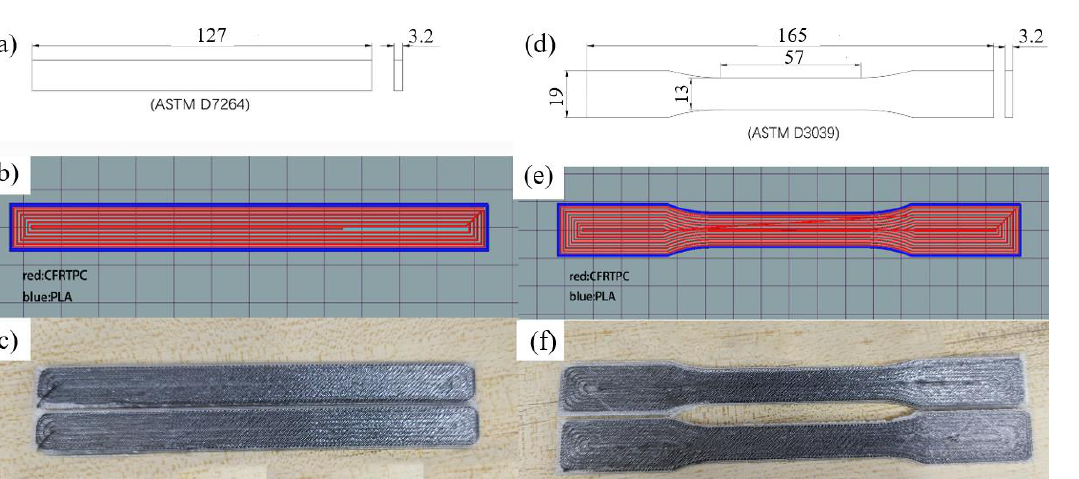
Figure 2. Standard sample, ( a ) size of standard three-point bending specimen, ( b ) intra-layer tracks of bending specimen, ( c ) the printed real bending specimens, ( d ) size of standard tensile specimen, ( e ) intra-layer tracks of tensile specimen, and ( f ) the printed real tensile specimens. Table 3. Printing parameters.